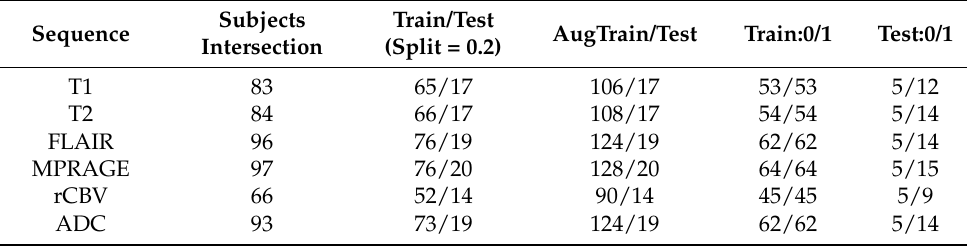
Table 1. Overview of patient data before and after data